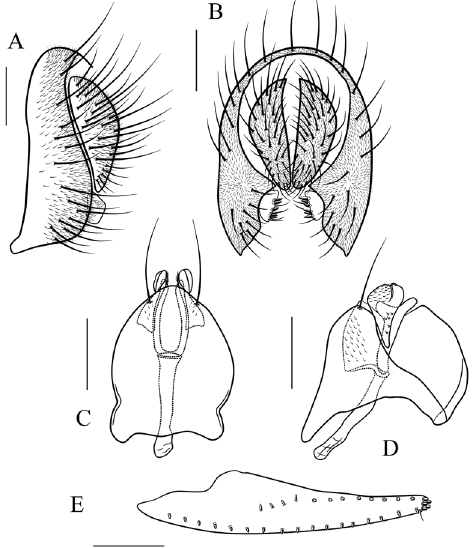
Figure 12. Scaptodrosophila melanogaster sp. n. A, B epandrium, surstylus and cercus (lateral and poste- rior views) C, D hypandrium, parameres, gonopods, aedeagus and aedeagal apodeme (ventral and lateral views) E oviscapt (lateral view). Scale bars 0.1 mm.